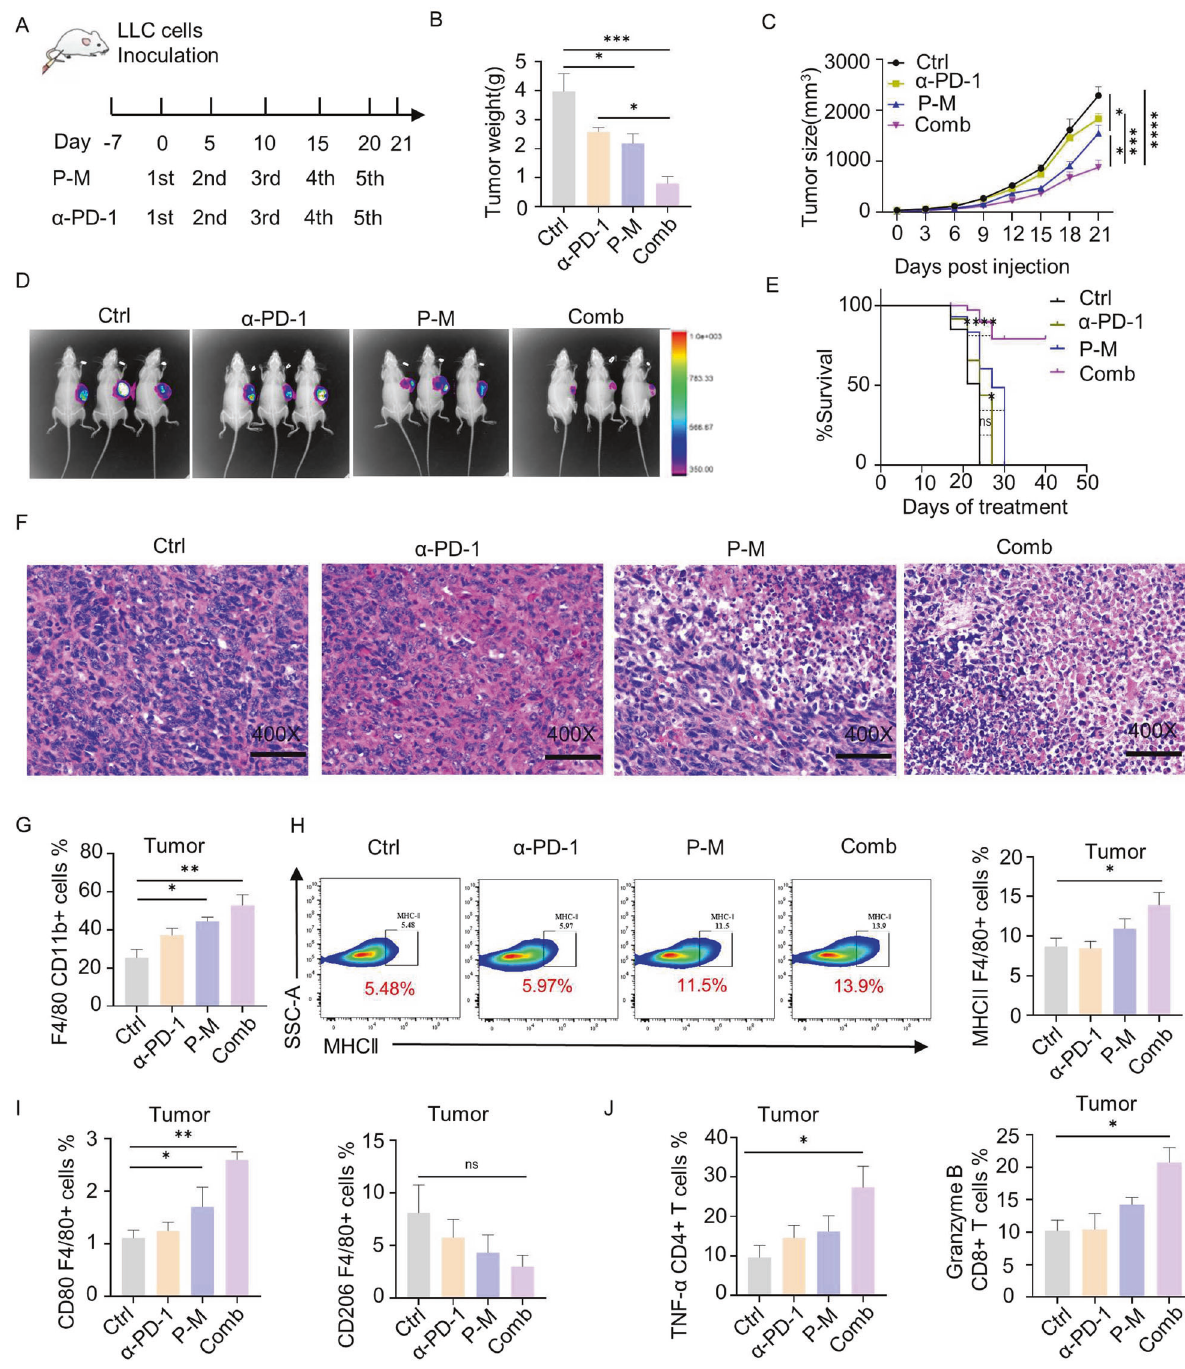
Fig. 4 PA-MSHA boosted the ef fi cacy of α PD-1 therapy in tumor. A Experimental strategy and schedule. Mice were subdivided into four groups: Control (injected with PBS), α PD-1, PA-MSHA, and PA-MSHA plus α PD-1. Treatment administered every fi ve days injection from day 0 to day 21. Tumor tissues and PBMC were obtained on day 21. B Tumor weight and ( C ) Tumor size was remarkably inhibited in combinational group. D In vivo fl uorescence images of LLC tumor-bearing mice at 21 days showed that the growth of tumor was signi fi cantly inhibited by combinational treatment. E Survival curve showing different groups of tumor-bearing mice. F H&E analysis of tumor tissue indicated that more immune cells were recruited into TME by PA-MSHA. Original magni fi cation, ×400. G The number of macrophages and ( H ) their MHC-II level in LLC tumors were signi fi cantly enhanced by PA-MSHA and combinational treatment. I The number and activity of M1 macrophages, which represented by CD80 was remarkably increased in LLC tumors, while CD206, marker of M2 macrophages was downregulated by treatments. J The expression of TNF- α of CD4 + T cells and Granzyme B of CD8 + T cells in different treatment groups. P-M is short for PA-MSHA. ( n = 6 mice/group, * P < 0.05, ** P < 0.01, *** P < 0.001, **** P < 0.0001.).